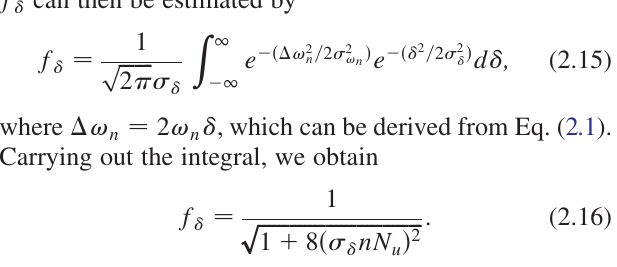
and the (cid:1) 1